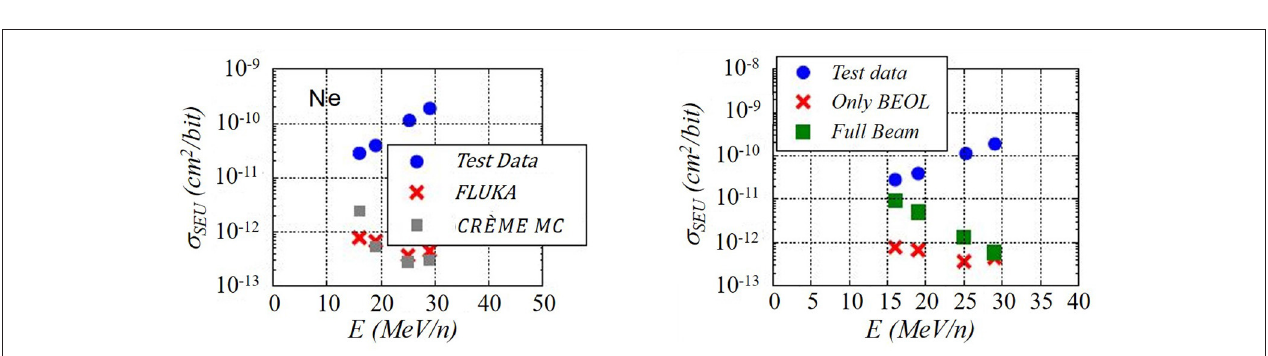
FIGURE 9 | FLUKA simulations of heavy ion irradiations of the ESA SEU Monitor at TAMU (left) and comparison of the cross sections of ions with LET of 1.8 MeV-cm ² /mg (right) [21]. BEOL, back end of line. Reproduced with permission from